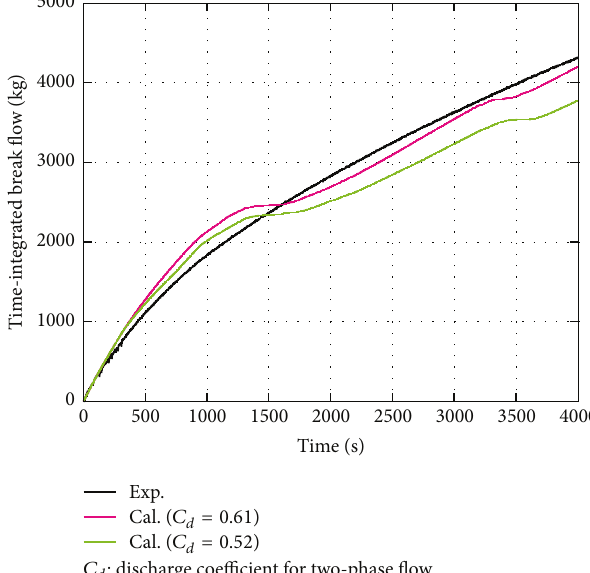
Figure 6: LSTF and RELAP5 results for time-integrated break flow in case of release of dissolved gas.